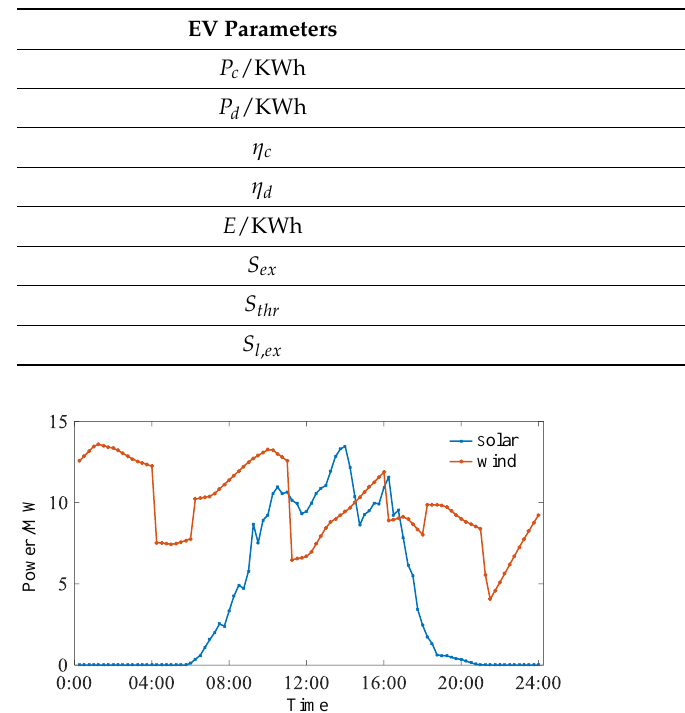
Table A3. The parameters of plugged-in EVs.